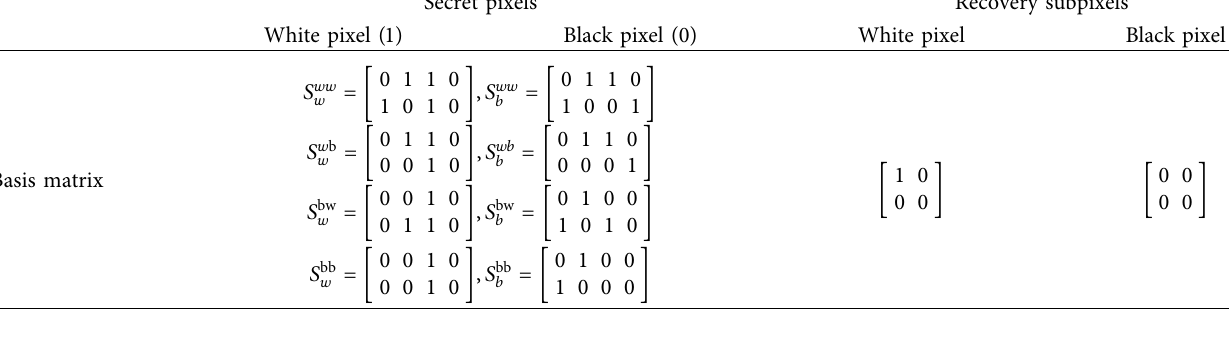
Table 1: The collections for (2,2)-EVCS example and the recovered